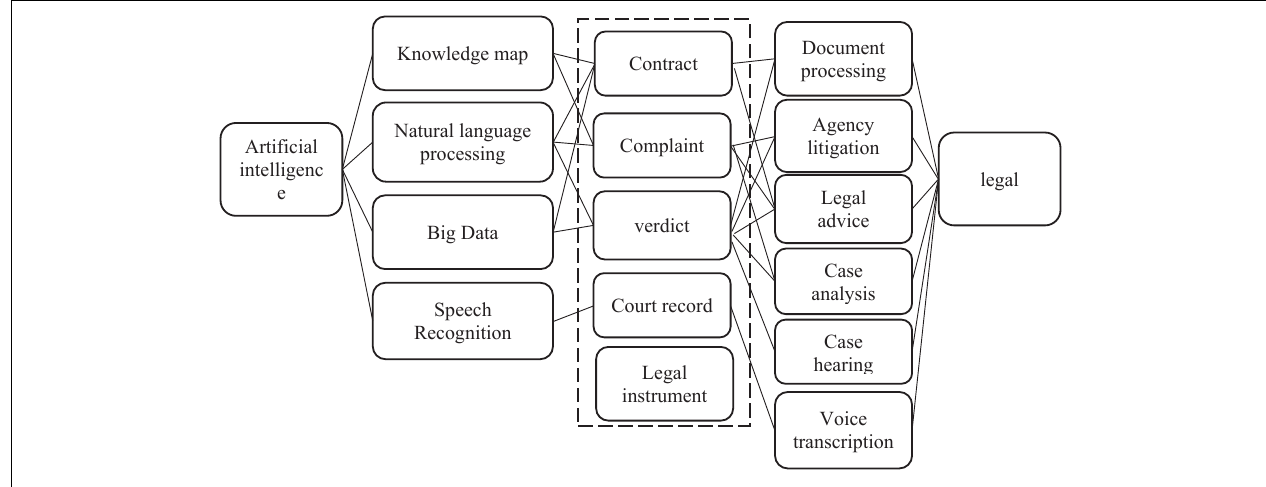
FIGURE 1 | Idea diagram of artificial intelligence technology applied in law.